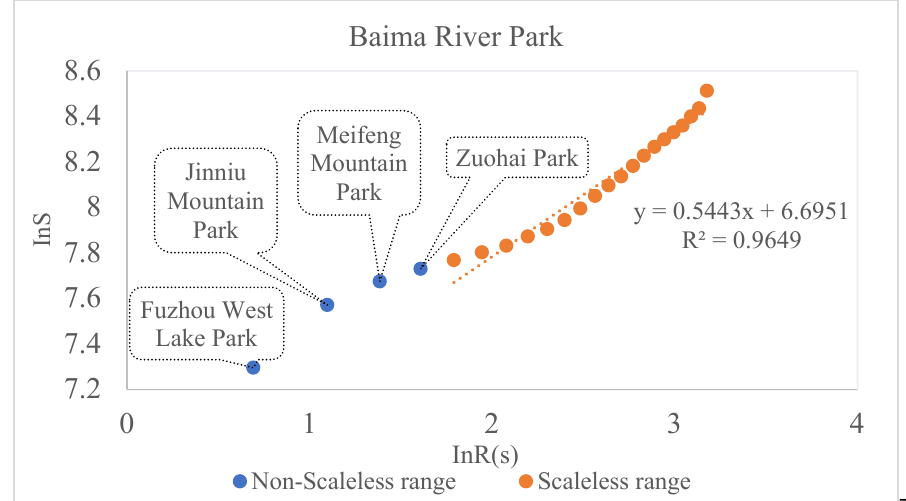
Figure 3. The log–log plot for the fractal aggregation dimension of park system centered on Baima River Park. To ensure the rigor of the argument, we analyzed parks in the non-scaleless range, which include: West Lake Park, Zuohai Park, Jinniu Mountain Park and Meifeng Moun- tain Park. These four parks are among the most popular parks in Fuzhou, with high fre- quencies of visitation, comprehensive infrastructure and well-organized spatial layout.